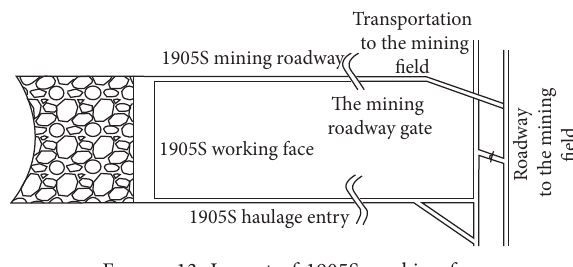
Figure 13: Layout of 1905S working Table 1: Properties of coal and immediate roof of 1905S entry.